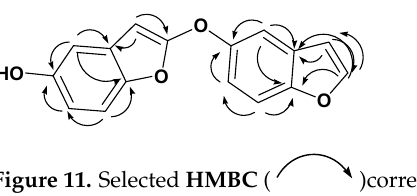
Figure 11. Selected HMBC ( ) correlations of compound 28.